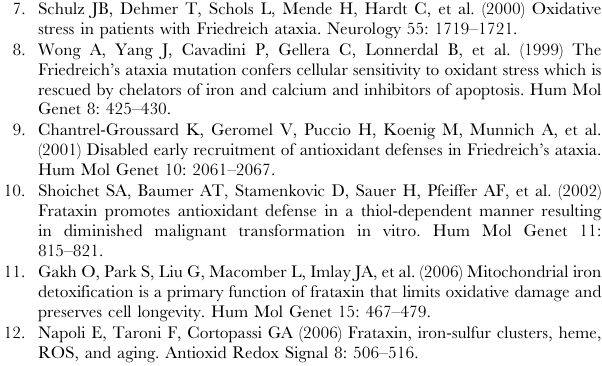
Dataset S1 SAM list of genes for the children’s cohort.